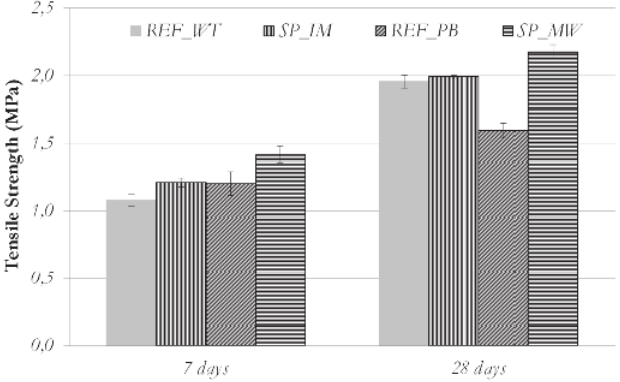
Effect of B. subtilis strain AP91 on the indirect tensile strength of mortars after 7 and 28 days of curing. Values are mean ± Sd (n = 3)